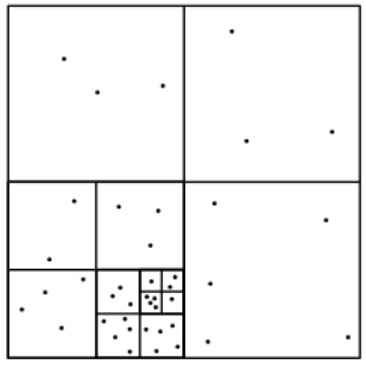
Figure 5. Subdivision of the total area into subareas. Source: the